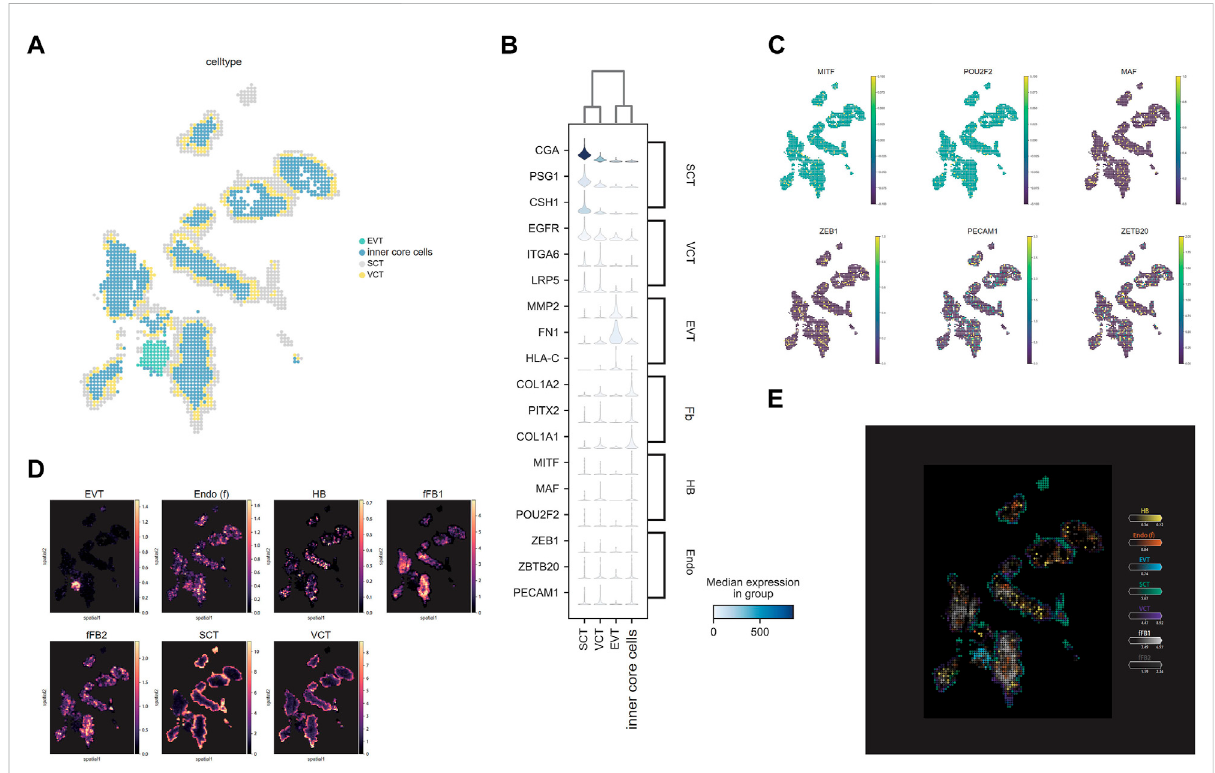
FIGURE 2 The localization of different cell types. (A) Unsupervised spatially constrained clustering of the villi. Bins are colored by their annotation. (B) The expression leveland (C) thedistributionofthemarkersforspeci fi ccelltypesinvilli. (D) Estimatedcellabundances(colorintensity)ofmajorcelltypes (color) across regions. (E) The distribution of cell types after deconvolution by cell2location showed in one